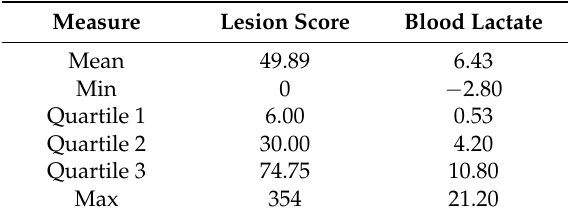
Table A1. Descriptive statistics regarding measures of relative change in skin lesions (number of lesions per pig) and blood lactate (mmol/L) following the fight, compared to before the fight, for the entire dataset ( n = 168).